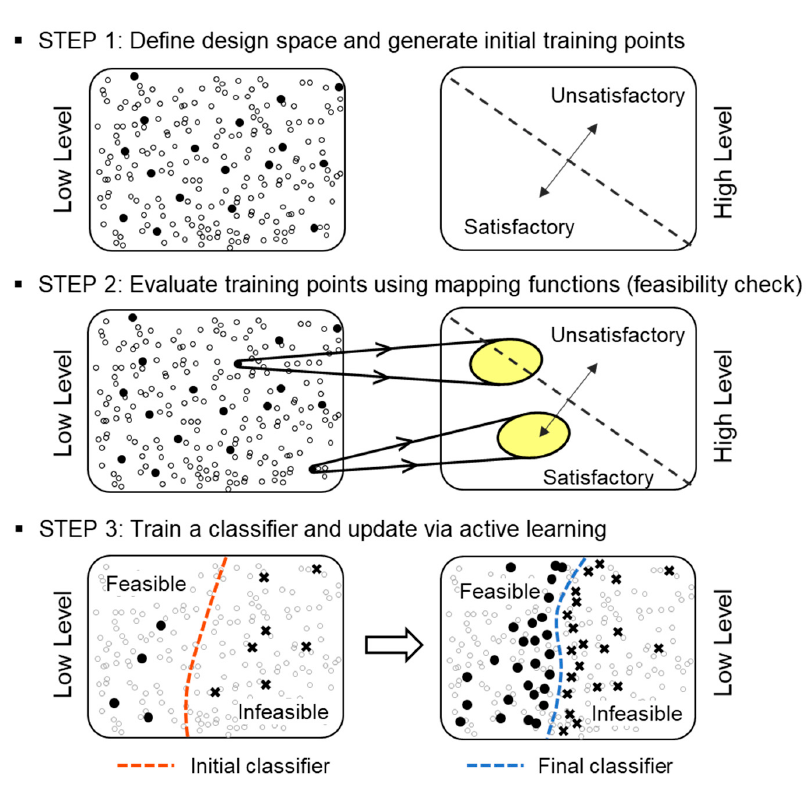
Figure 3. Graphical procedure of inductive design exploration method(IDEM) with active learning.